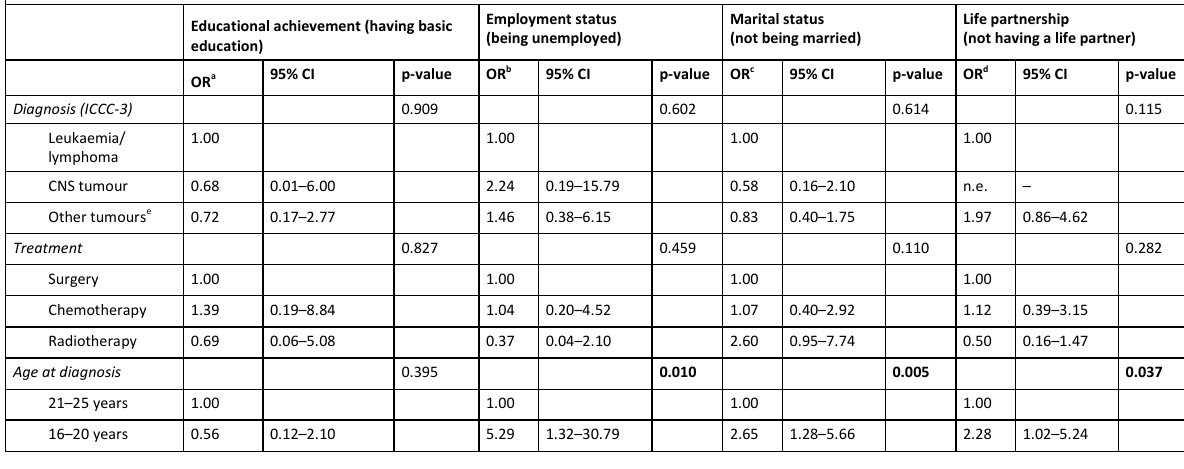
Table 4: Cancer-related variables associated with educational achievement, employment status, marital status and life partnership in TYA cancer survivors from univariable exact logistic regression models. Educational achievement (having basic